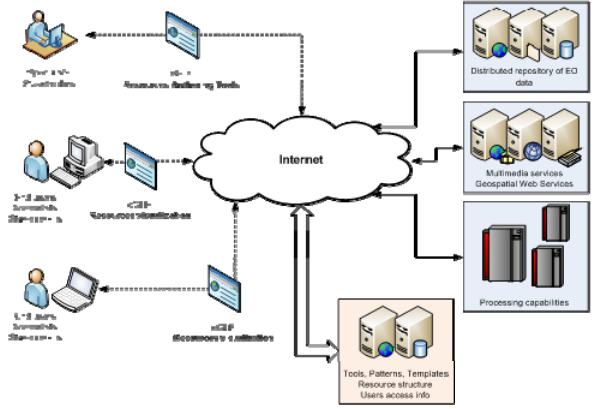
Figure 7. eGLE Platform